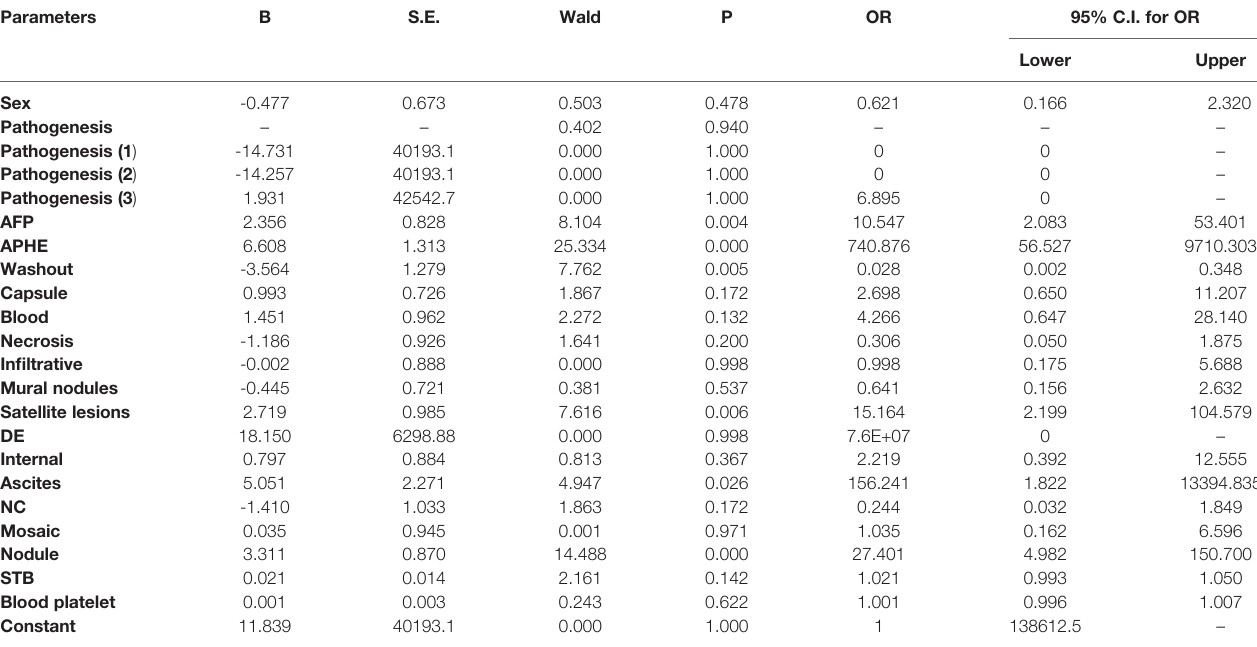
TABLE 3 | The results of multivariate logistic regression analysis. Parameters B S.E. Wald P OR 95% C.I. for